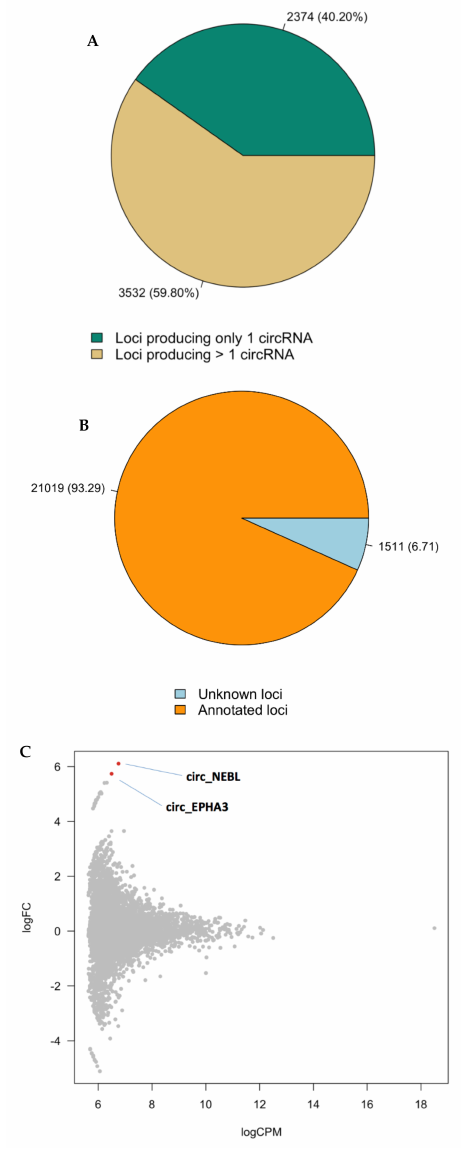
Figure 3. Di ff erential expression of circRNAs in BPD brains. Pie-chart representing the numbers and the percentages of the circRNAs from annotated loci and those from unknown loci, respectively ( A ). Pie-chart representing the numbers and percentages of loci producing only one circRNA and those giving rise to multiple circles, respectively ( B ). MA plot showing the two di ff erentially expressed circular RNAs at FDR < 0.1 in subjects with BPD versus healthy controls ( C